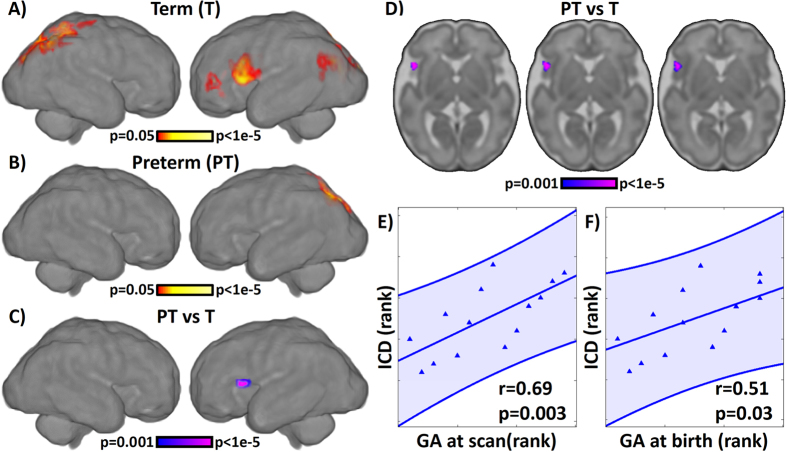
Comparison of preterm (PT) - and term (T) -born fetuses using voxel-level connectivity.Single group maps for (A) term and (B) preterm-born fetuses, showing putative hub regions in the fetal brain at 29.6 weeks. Significant differences (p < 0.05, corrected) between preterm- and term-born fetuses were observed in eventual left hemisphere language regions in the frontal lobe as shown on (C) surface rendering, and (D) axial slices. No regions exhibited increased ICD for preterm-born fetuses compared to term born fetuses. For the preterm-born fetuses, ICD values extracted from a seed centered on the peak difference (27 mm left, 18 mmanterior, 5 mm inferior of the center of image data) were significantly correlated with both gestational age (GA; panel (E)) at scan (r = 0.69, p = 0.003, df = 12) and (F) at birth (r = 0.51, p = 0.03, df = 12) using one-tailed Spearman rank correlation.